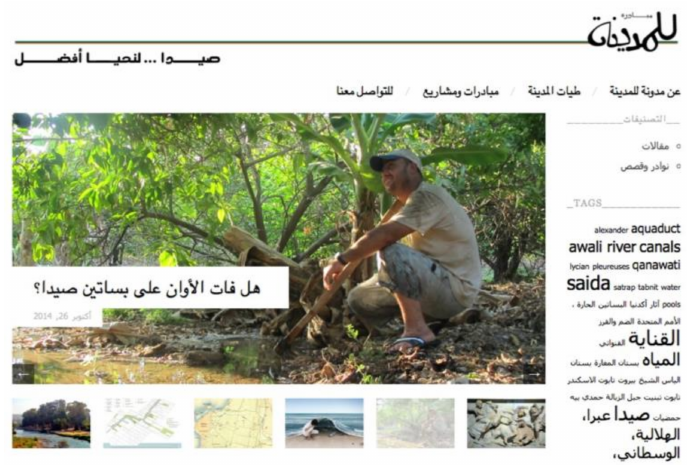
Figure 6. ‘Lil Madina’ website profiling the historic Qanaya and Saida orchards as a collective landscape heritage of